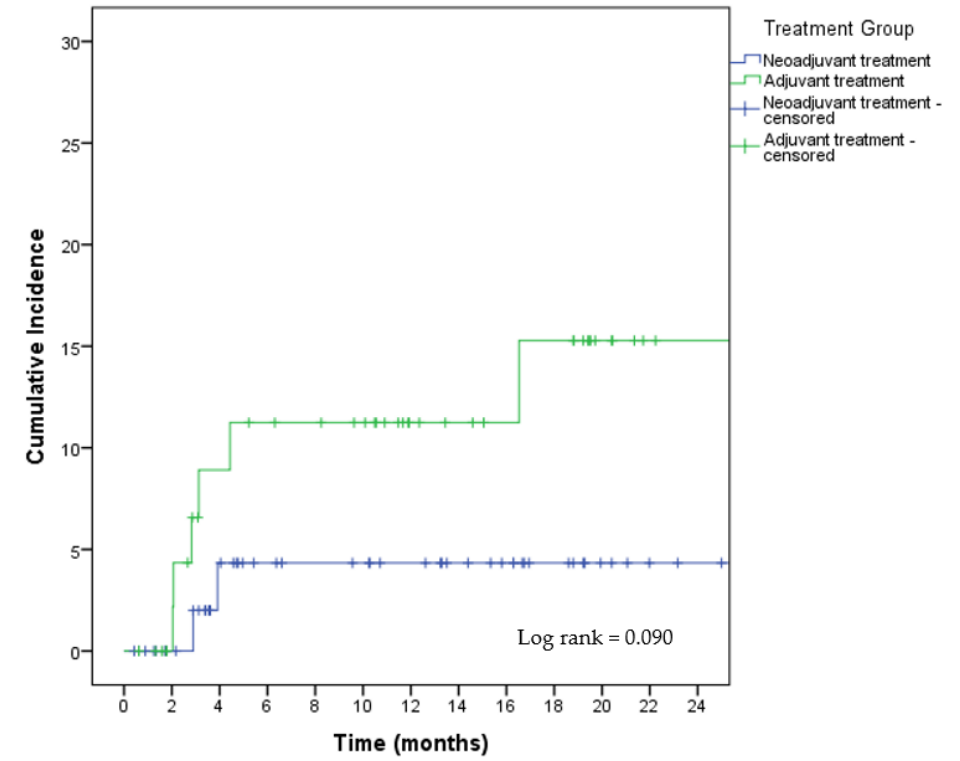
Figure 1. Actuarial incidence of implant loss.